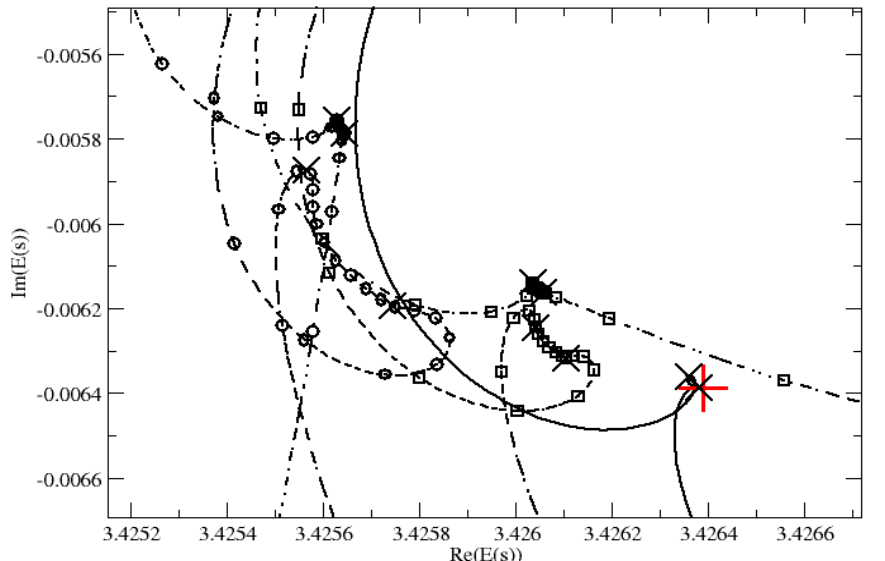
Figure 4. Trajectories (with z 0 = 0) in the case ζ = λ = 0.12 for the problem I (solid line), problem II (dashed lines), and problem III (dash-dotted lines). Calculations were carried out for various values of N, i.e., ○ —N = 100, □—N = 600. Signs + and x indicate the position of the resonance and optimal point, respectively. Data are presented in a.u.